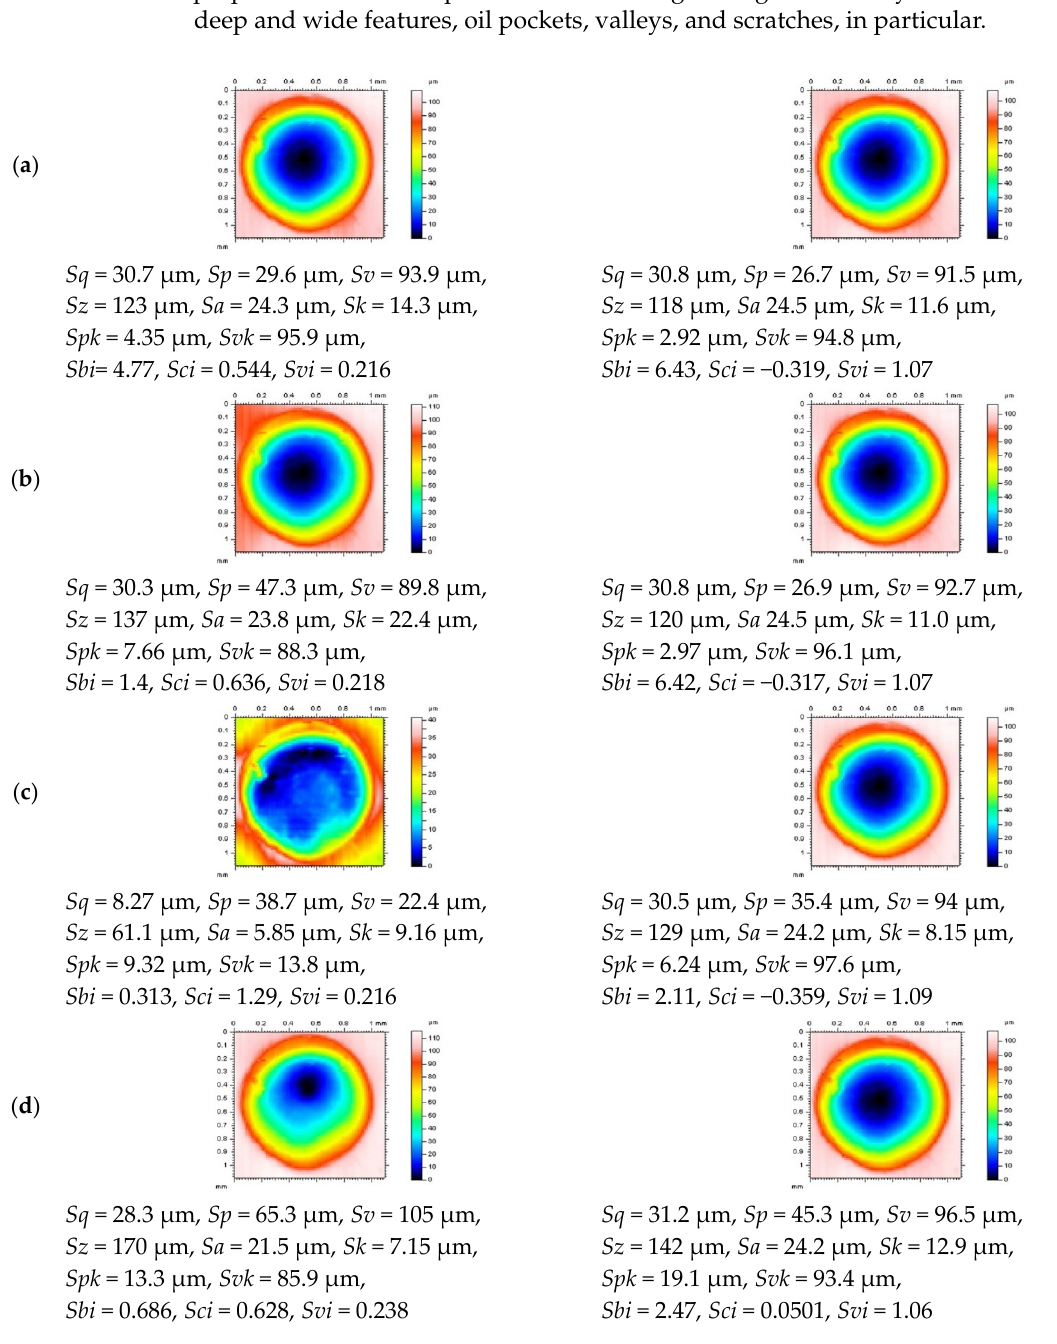
Figure 7. The edge-located dimple areas and surface topography parameters, respectively, received from the turned cylindrical detail containing burnished dimples, after areal form removal by the regular algorithms (left column) and the same procedures with threshold modification (right column) and after application of a polynomial plane of 2nd ( a ) and 4th ( b ) degree or regular ( c ) and robust ( d ) Gaussian regression filters with cut-off = 0.8 mm.